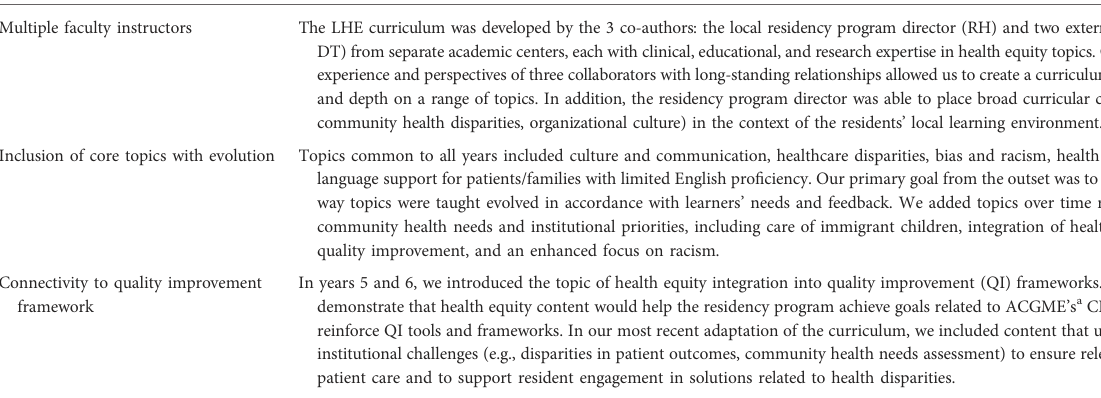
TABLE 1B Leaders in Health Equity (LHE) content principles and detailed